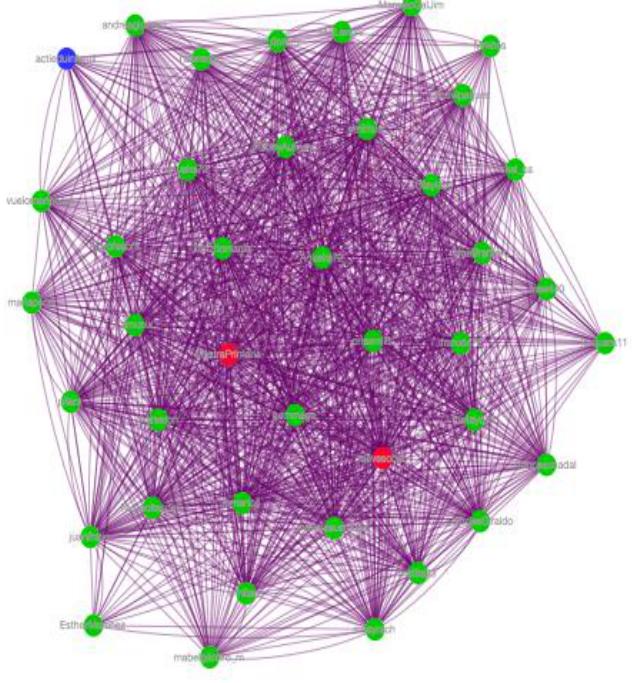
Figure 8 . Representation of the Apps relations network topology. In this network, the leader is one of the two most connected members (see Figure 8, the nodes in red), however the rest of the members are also highly connected with each other, conforming a tight network. The in-degree and out-degree centrality representation confirms that all members are connected at least to six people and most of them are connected to more than 20 people in the community. Other networks similar to Apps are Tools, Music, and Film . Words and Robot also have a leader and many highly connected members; however, the number of peripheral participants is higher than in the previous four